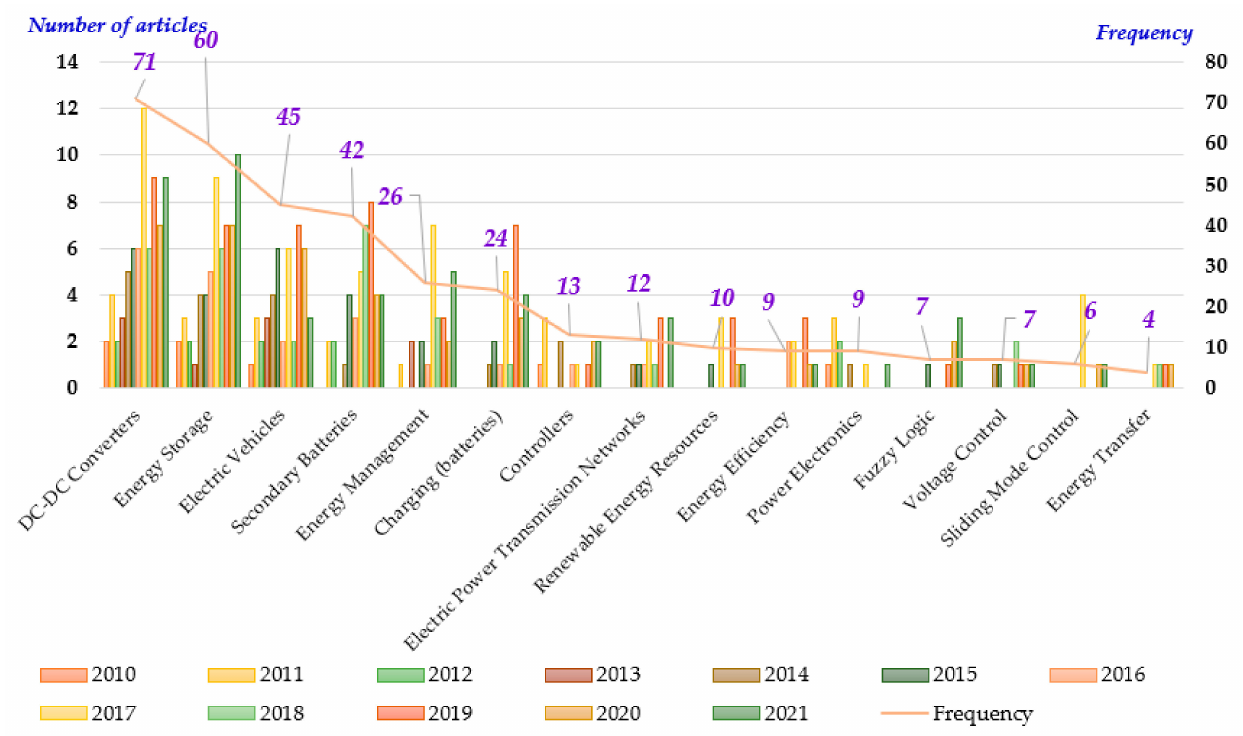
Figure 6. Distribution of topmost 15 keywords over the year 2010 to